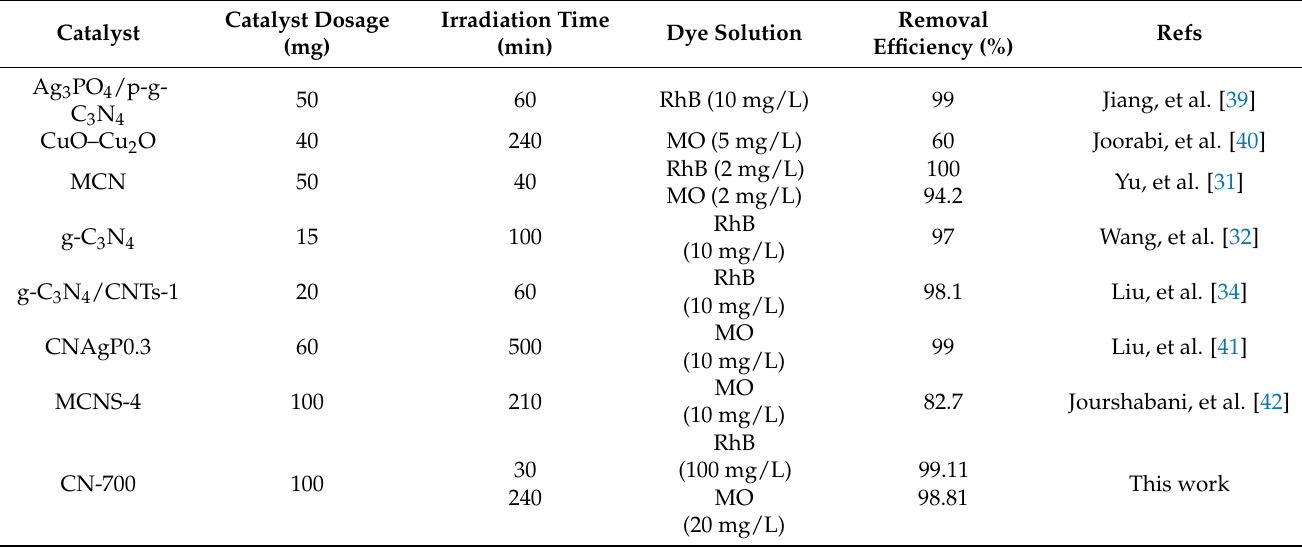
Table 5. Comparison of different catalysts for dyes removal under visible